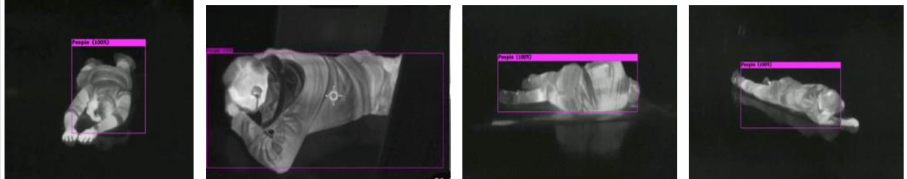
Figure 14. Detection of human lying on the floor from different viewing